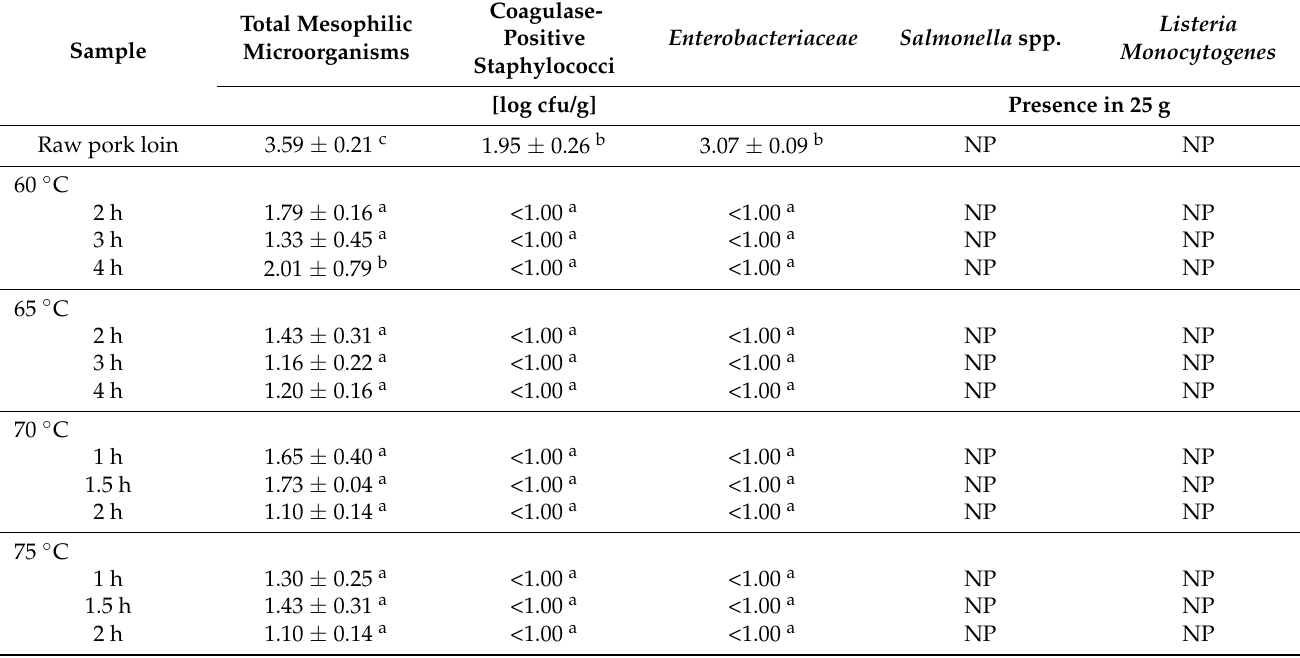
Table 4. The microflora of raw and sous vide cooked pork loin (mean ± SEM).